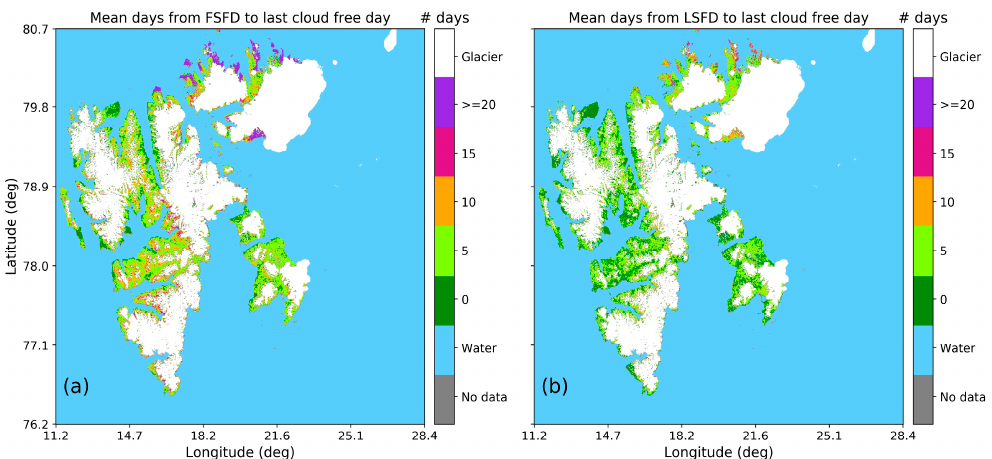
Figure A1. Average number of cloud-free days per year.